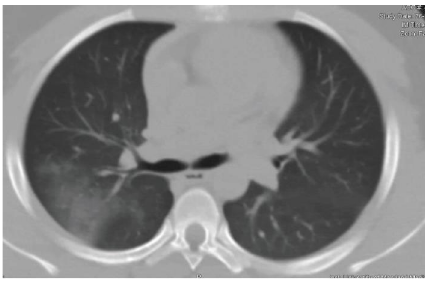
Figure 4: Axial view of CT chest scan showing a signifcant res- olution of bilateral ground-glass opacities after treatment with